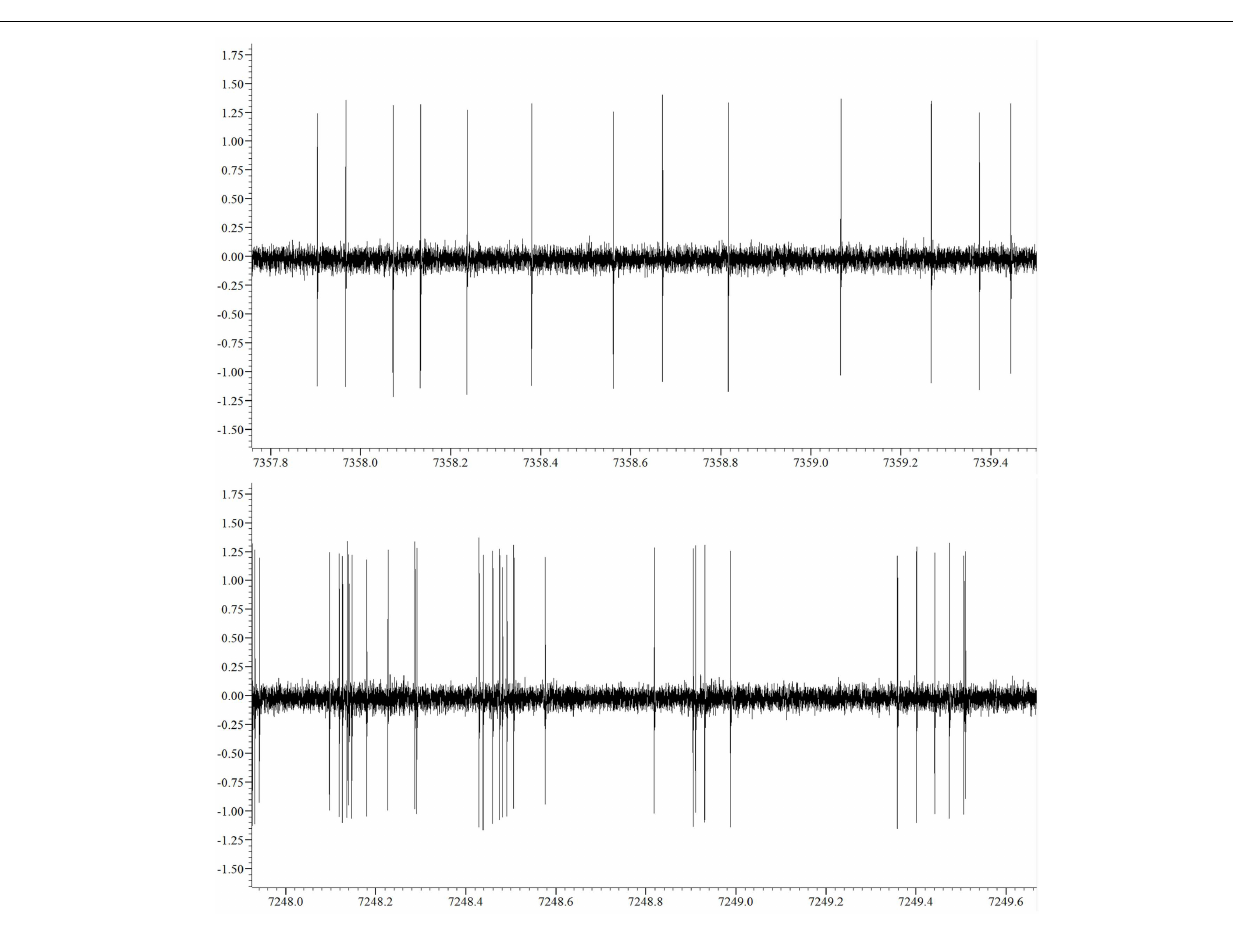
FIGURE 3 | Sample non-bursting (upper panel) and bursting (lower panel) segments of the neuronal activity recorded .